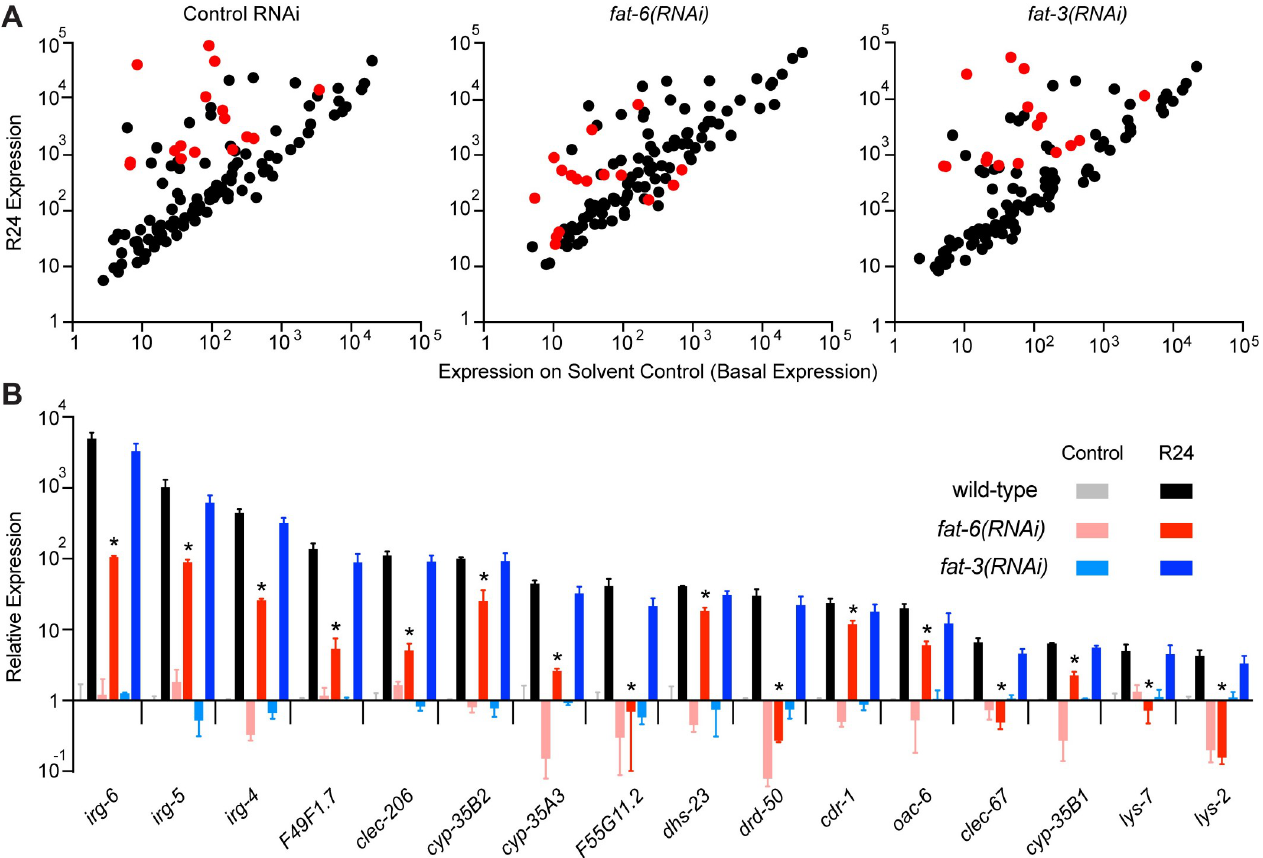
Fig 3. Stearoyl-CoA desaturase activity is required for the induction of an innate immune response in C . elegans . A. Dot plots showing the NanoString nCounter gene expression analysis of 118 immune and stress response genes in C . elegans grown on the indicated RNAi bacteria and exposed to control or R24. Each dot represents one gene. Red dots highlight the 16 genes whose R24-mediated induction is significantly suppressed in fat-6(RNAi) animals. Data are the average of two independent replicates. B. The expression of the 16 fat-6 -dependent genes in the indicated genotypes and conditions is shown relative to wild-type animals exposed to control. Significance was determined using t -tests, � p < 0.05. Data are the average of two independent replicates, each normalized to three control genes and expressed relative to the baseline condition (wild-type animals exposed to control) for each gene. Error bars show standard